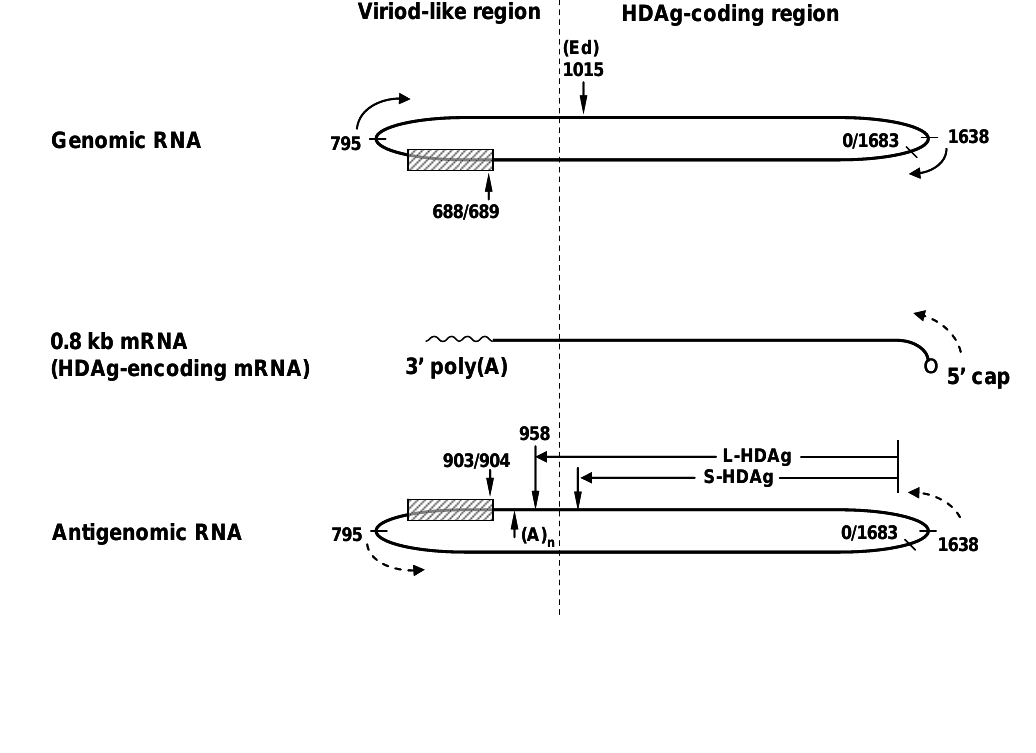
Figure 1. Schematic diagrams of the structure of HDV RNAs. The antigenomic RNA and HDAg-encoding mRNA are detected only in the cells. The nucleotide numbers are according to Makino et al. [24] and represented in genomic orientation on both the genomic and antigenomic strands. The genomic RNA is represented in clockwise orientation, while the antigenomic RNA and HDAg-encoding mRNA are counterclockwise. Nucleotides 688/689 and 903/904 are ribozyme cleavage sites for genomic and antigenomic RNAs, respectively. The hatched boxes represent the ribozyme represents polyadenylation domains. Nucleotides 1015 (Ed) denotes RNA editing site. (A) n